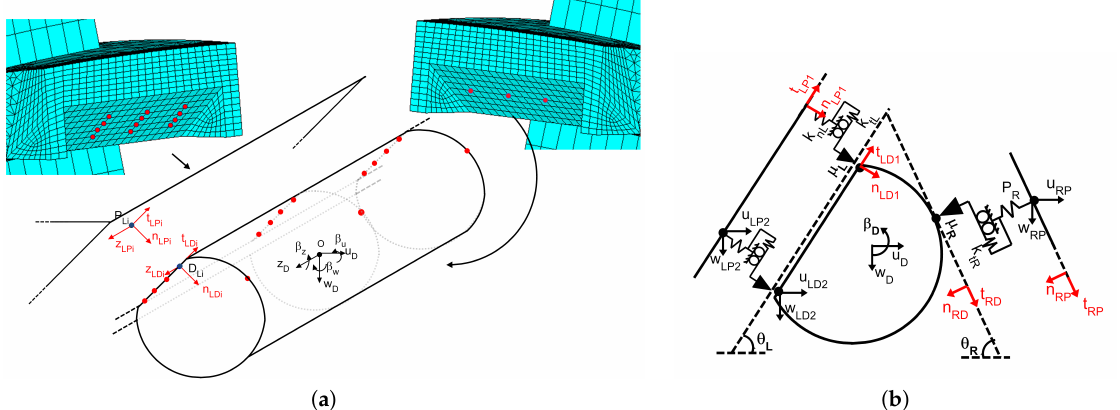
Figure 2. ( a ) Contact model with three contact springs. ( b ) Contact patches on the blade platforms and on the strip